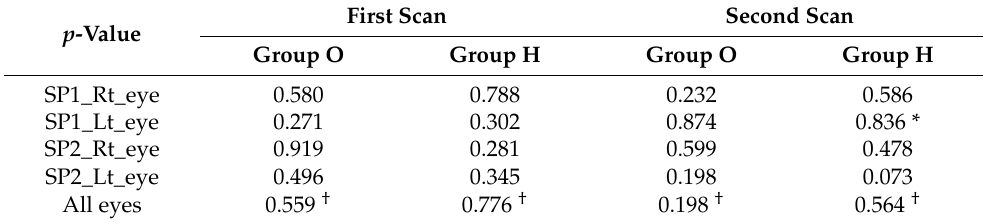
Table A7. Differences between the ONSD measurement value and the reference